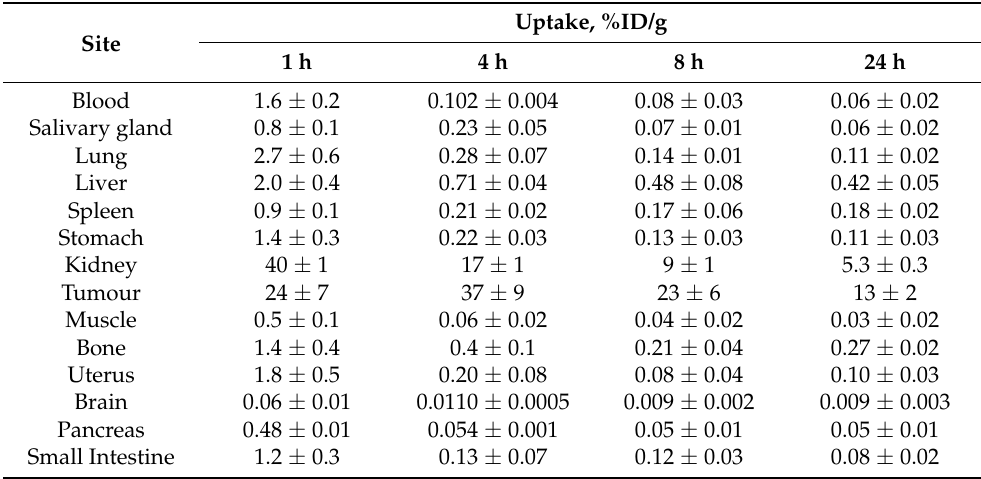
Table 3. Biodistribution of [ 99m Tc]Tc-ZHER2:41071 in BALB/C nu/nu mice bearing SKOV3 xenografts. Data are expressed as %ID/g and are averages from four mice ± SD. Site